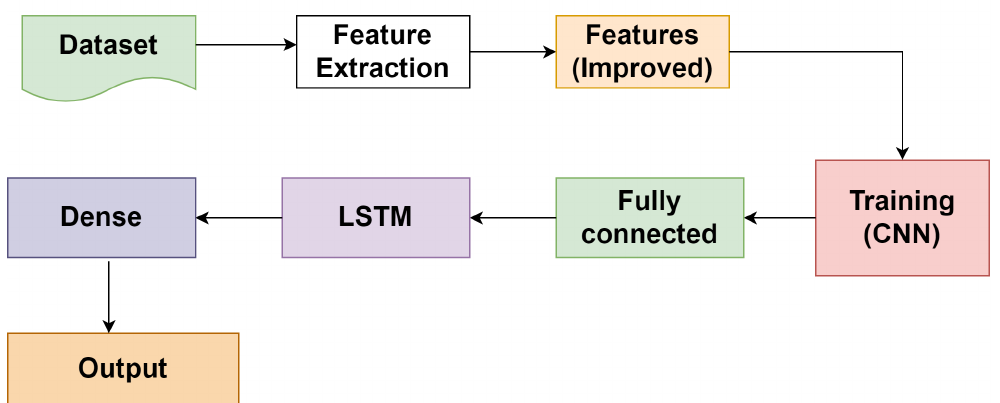
Figure 1. The Proposed hybrid